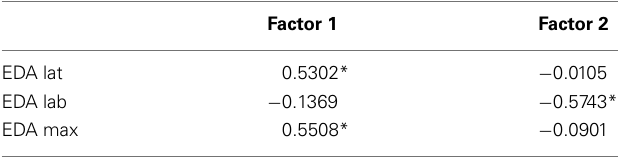
Table 3 | Correlation indices (rho) between PCL-R scores and EDA measures for pleasant and neutral stimuli .